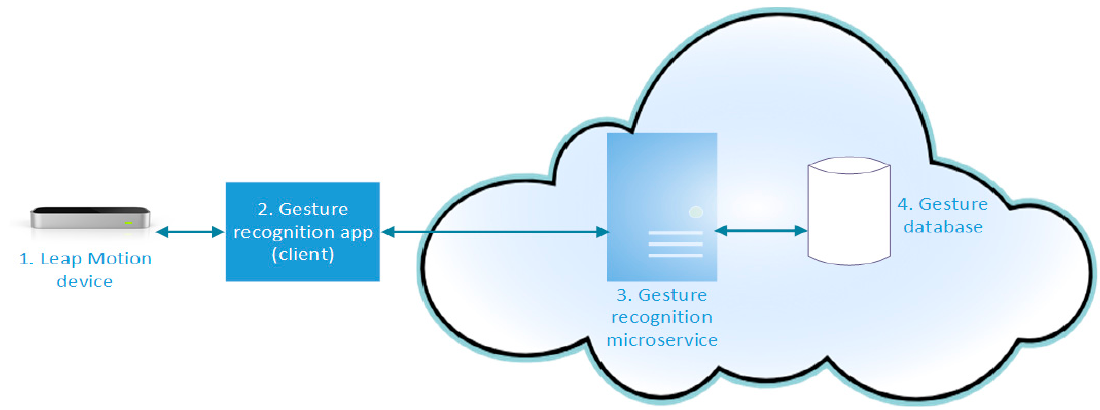
Figure 2. Outline of a system.